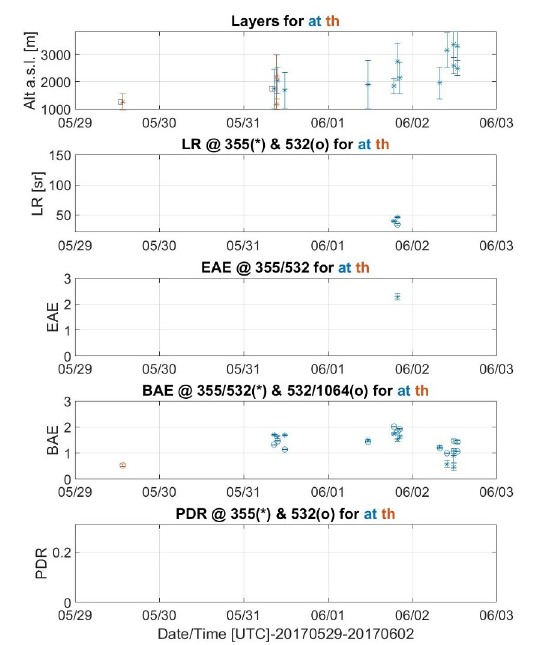
Fig. 2. Intensive variables for “at” and “th”, event 29 May - 2 June 2017. Squares show the layers with BB origin.